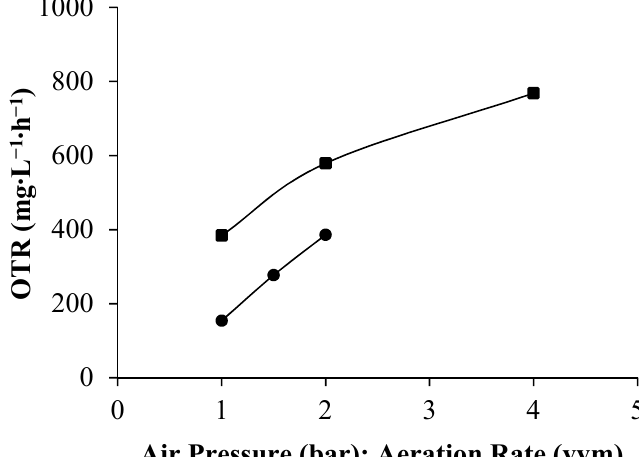
Figure 1. Variation of oxygen mass transfer rate (OTR) under different operating conditions: pressurized bioreactor ( ■ )—OTR vs. air pressure; airlift bioreactor ( ● )—OTR vs. aeration rate.